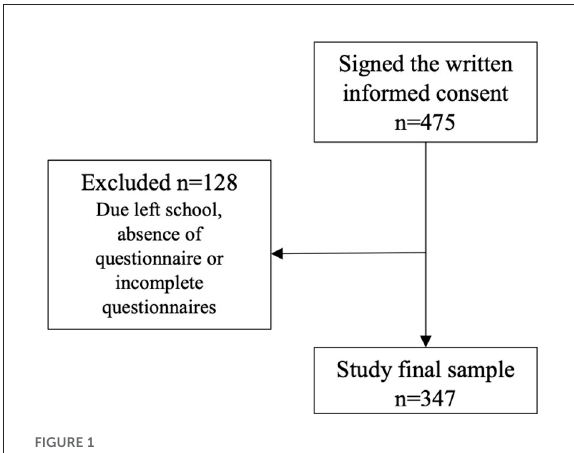
FIGURE1 Flow diagram of participant inclusion process. Federal District, Brazil,